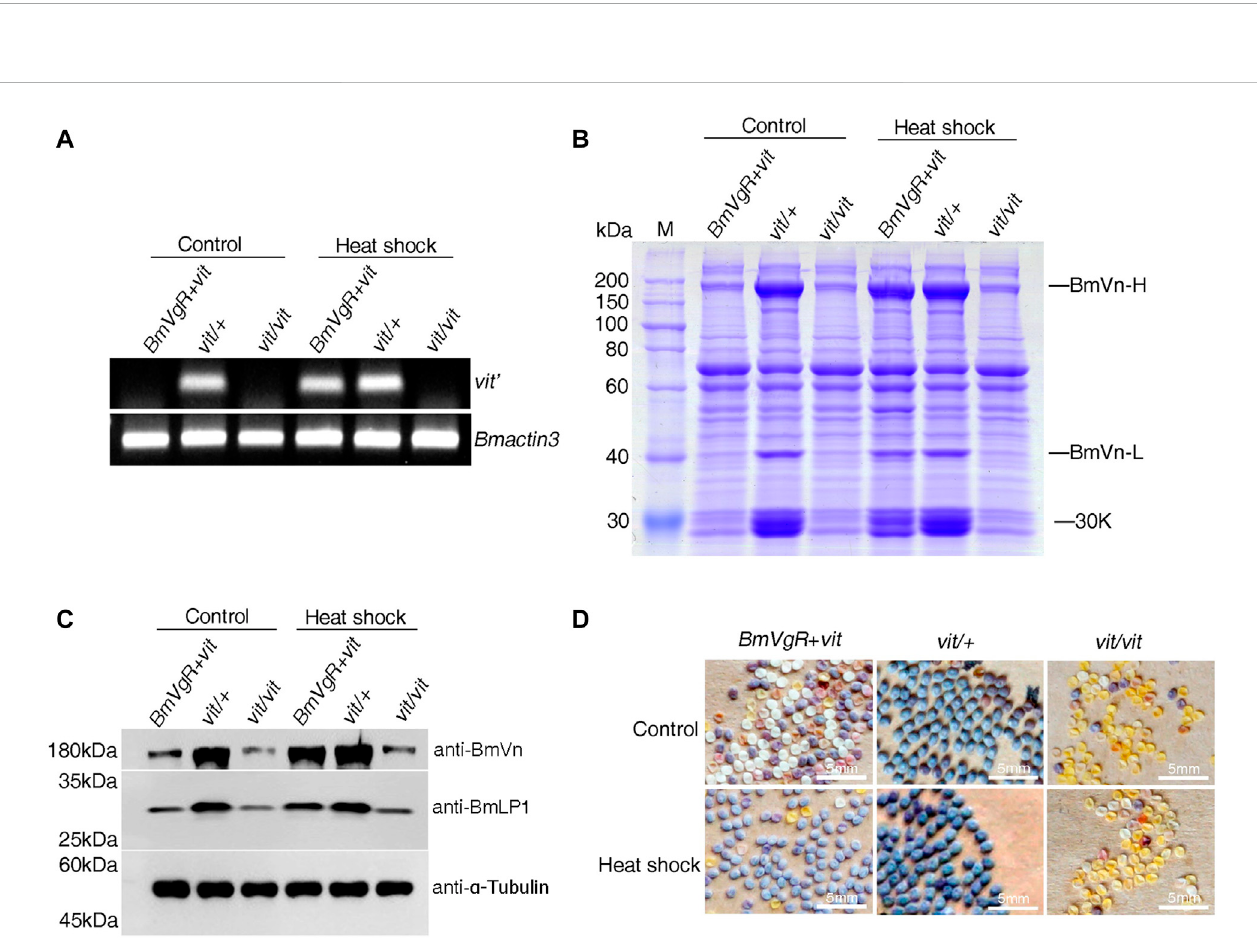
FIGURE 7 BmVgR expression and phenotype of the transgenic BmVgR + vit after heat shock. (A) Vit ’ gene fragment in the ovaries of the BmVgR + vit after heat shockbyRT-PCR; Bmactin3 isusedasaninternalreference. (B) Thedetection oftotalproteins intheovariesofthe BmVgR+vit afterheat shocktreatmentby usingSDS-PAGE. (C) DetectionofBmVnandBmLP1proteinsintheovariesofthe BmVgR+vit afterheatshocktreatmentbyusingwesternblotting. α -Tubulin wasusedasaninternalreference.Anti-BmVg,anti-BmLP1rabbit,andHRP-conjugatedgoatanti-rabbitIgG(H+L)antibodieswereusedatadilutionof1: 10,000. (D) The phenotype of silkworm eggs in the offsprings of the BmVgR + vit after heat shock. Vit/+ was used as a control. Heat shock, treatment at 27 ° C, 32 ° C, 37 ° C, and 42 ° C for 1 h on days 1, 3, 5, and 7 of pupation, respectively. Control, treatment at 27 ° C from corresponding stages of pupation like